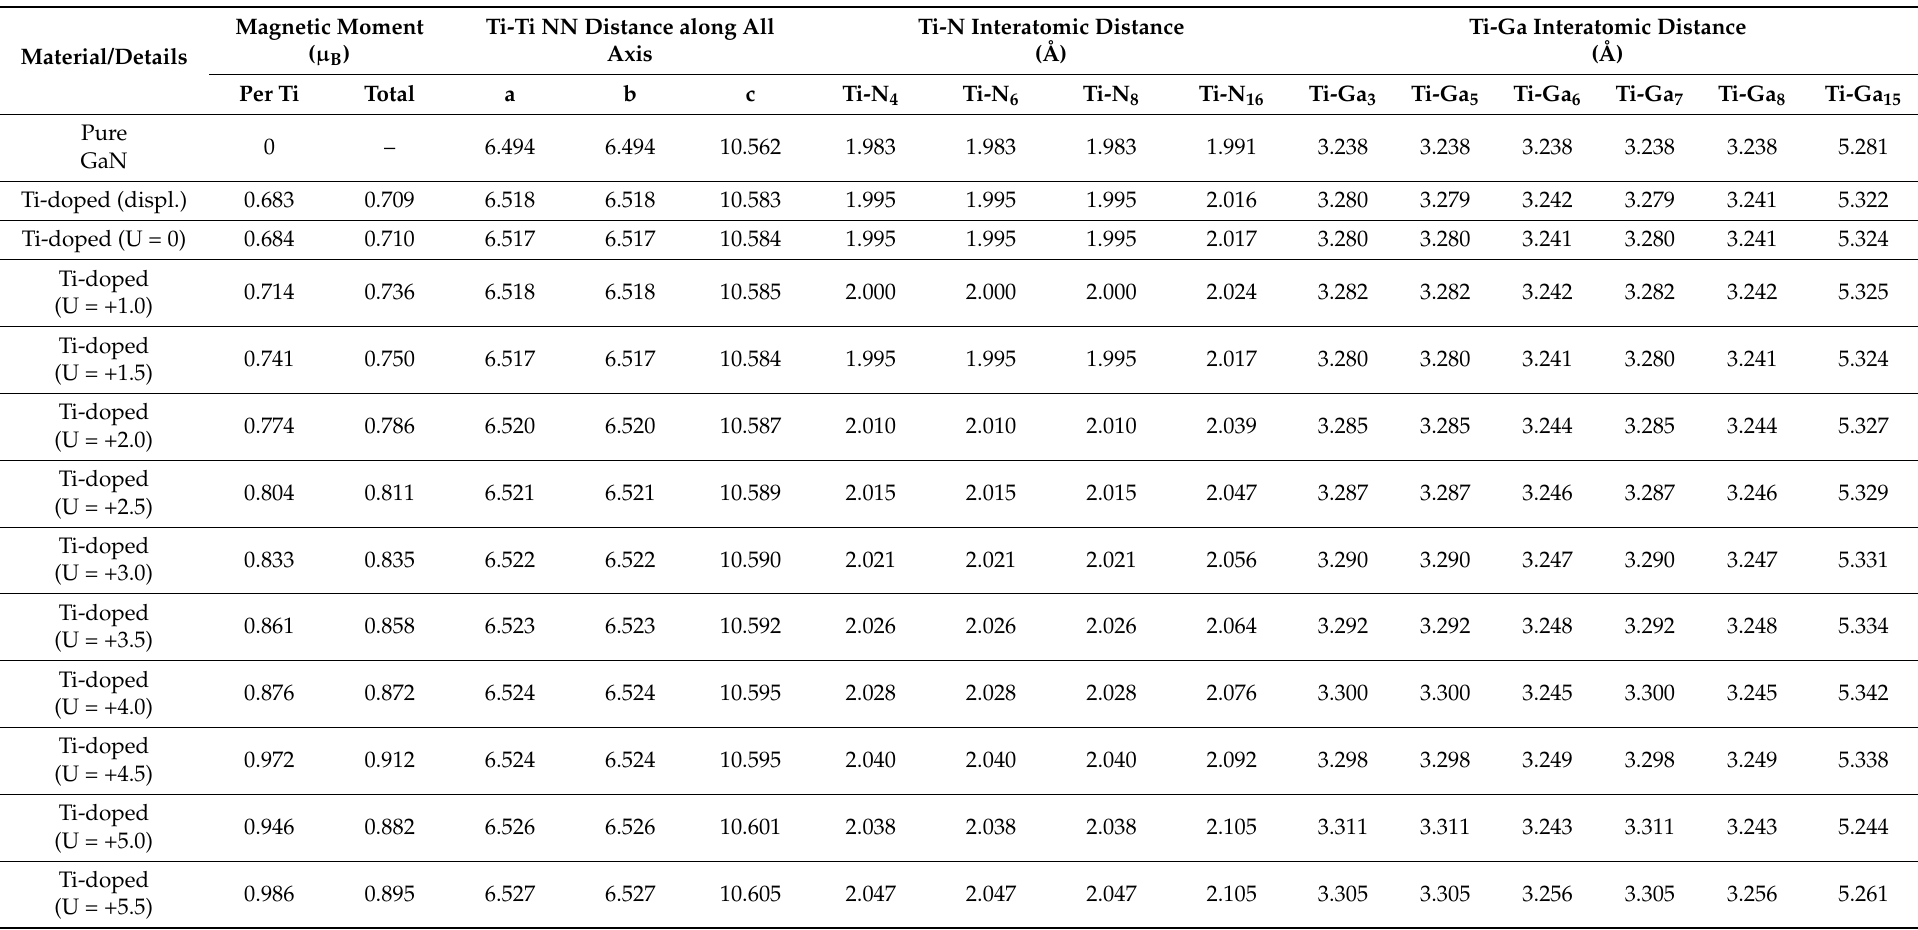
Table 2. The values of magnetic moment, and structural parameters computed for pure GaN and Ti:GaN without and with Hubbard correction. The values of Ti-Ti nearest neighbor distance along three axes and distance of Ti to different N atoms and G atoms are also